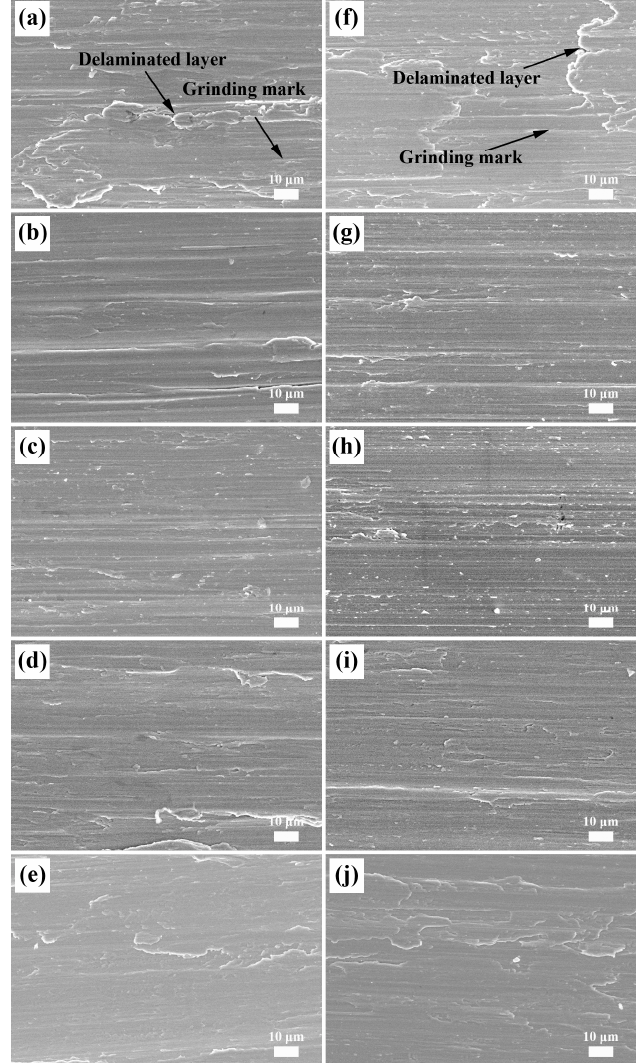
Figure 6. The surfaces of ( a , f ) cp-Ti; ( b , g ) Ti-5Al; ( c , h ) Ti-5Cr; ( d , i ) Ti-5Sn; ( e , j ) Ti-5V alloys ground using an SiC wheel at revolution speeds of 5000 rpm (left) and 10,000 rpm (right).